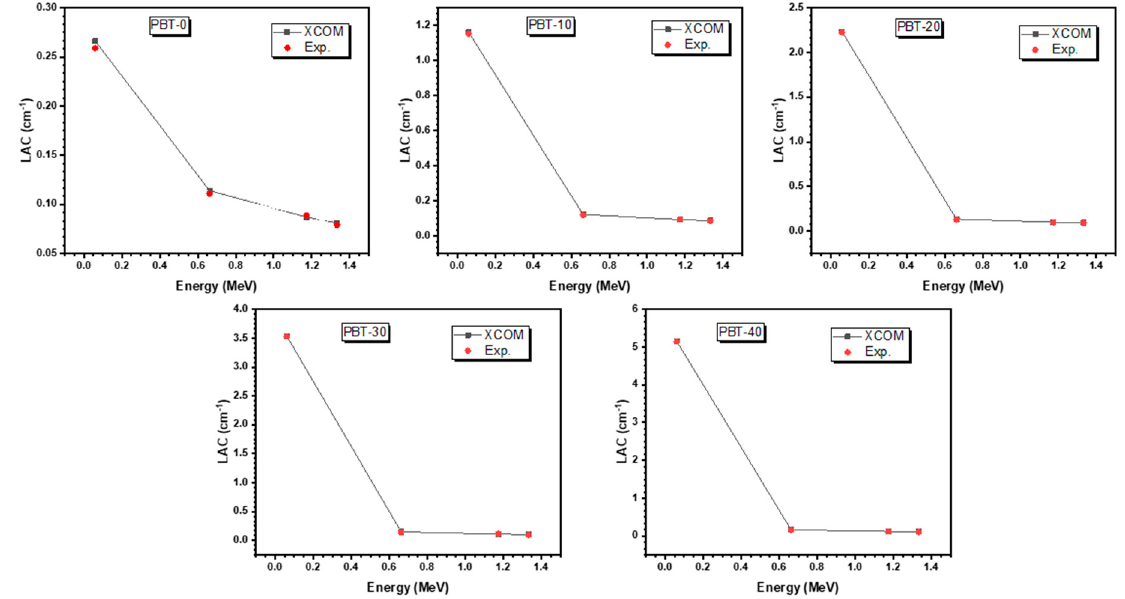
Figure 3. The theoretical and experimental LAC of the five investigated samples.